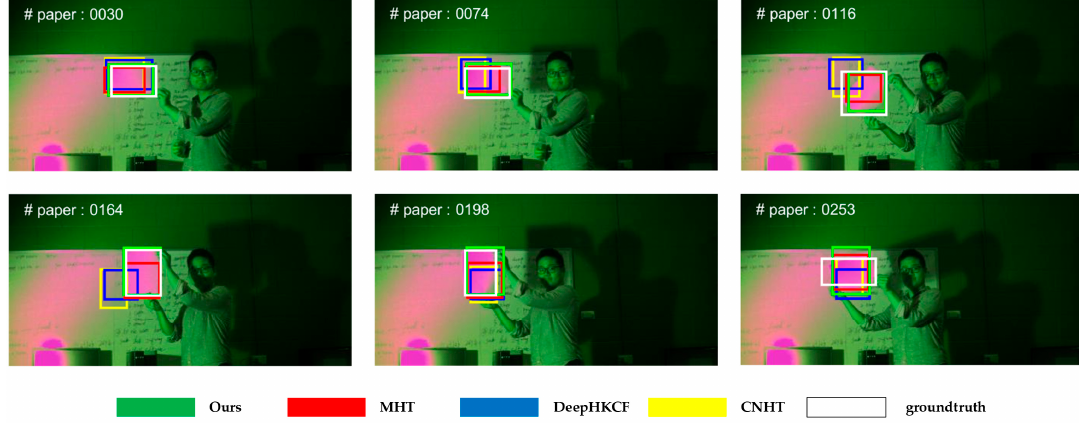
Figure 11. Tracking result of the paper sequence.